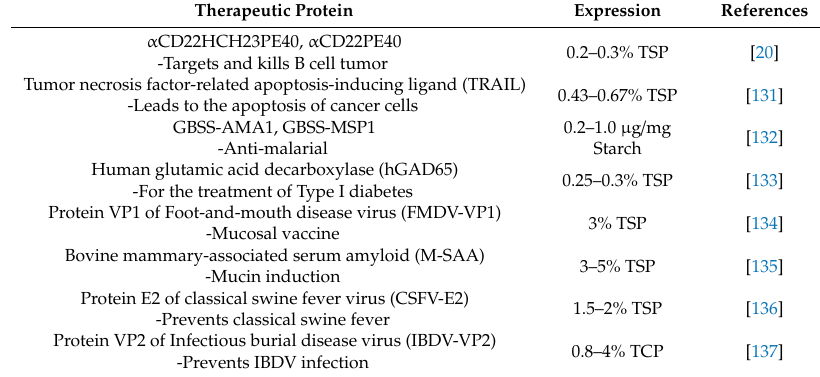
Table 5. Protein-based drugs produced in Chlamydomonas reinhardtii chloroplasts. Therapeutic Protein